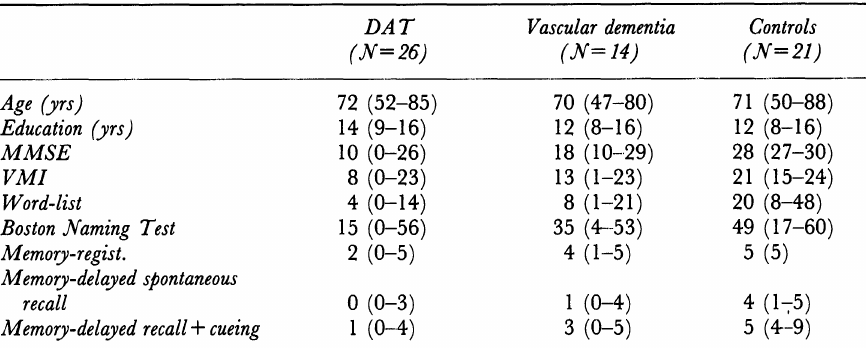
TABLE I. Characteristics and neuropsychological performance of dementia patients and control subjects (mean and range) DAT Vascular dementia Controls